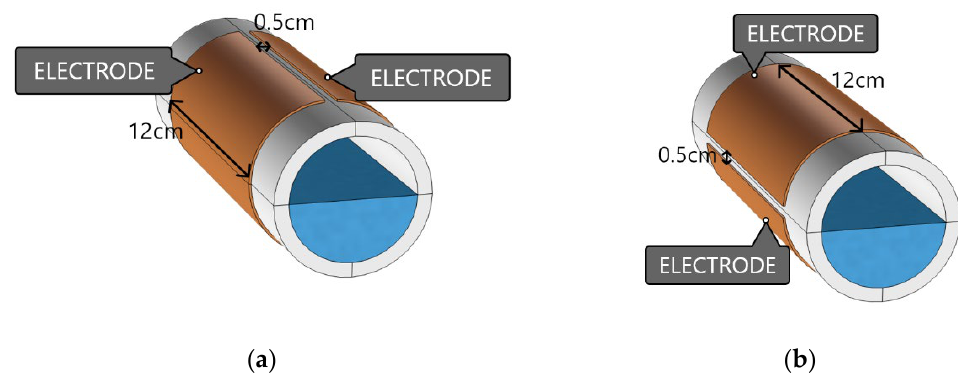
Figure 4. Diagram of a concave sensor for two-phase stratified flow, ( a ) Horizontal orientation, ( b ) Vertical orientation. Table 2. Measured capacitance values at different void fractions for the concave sensor.